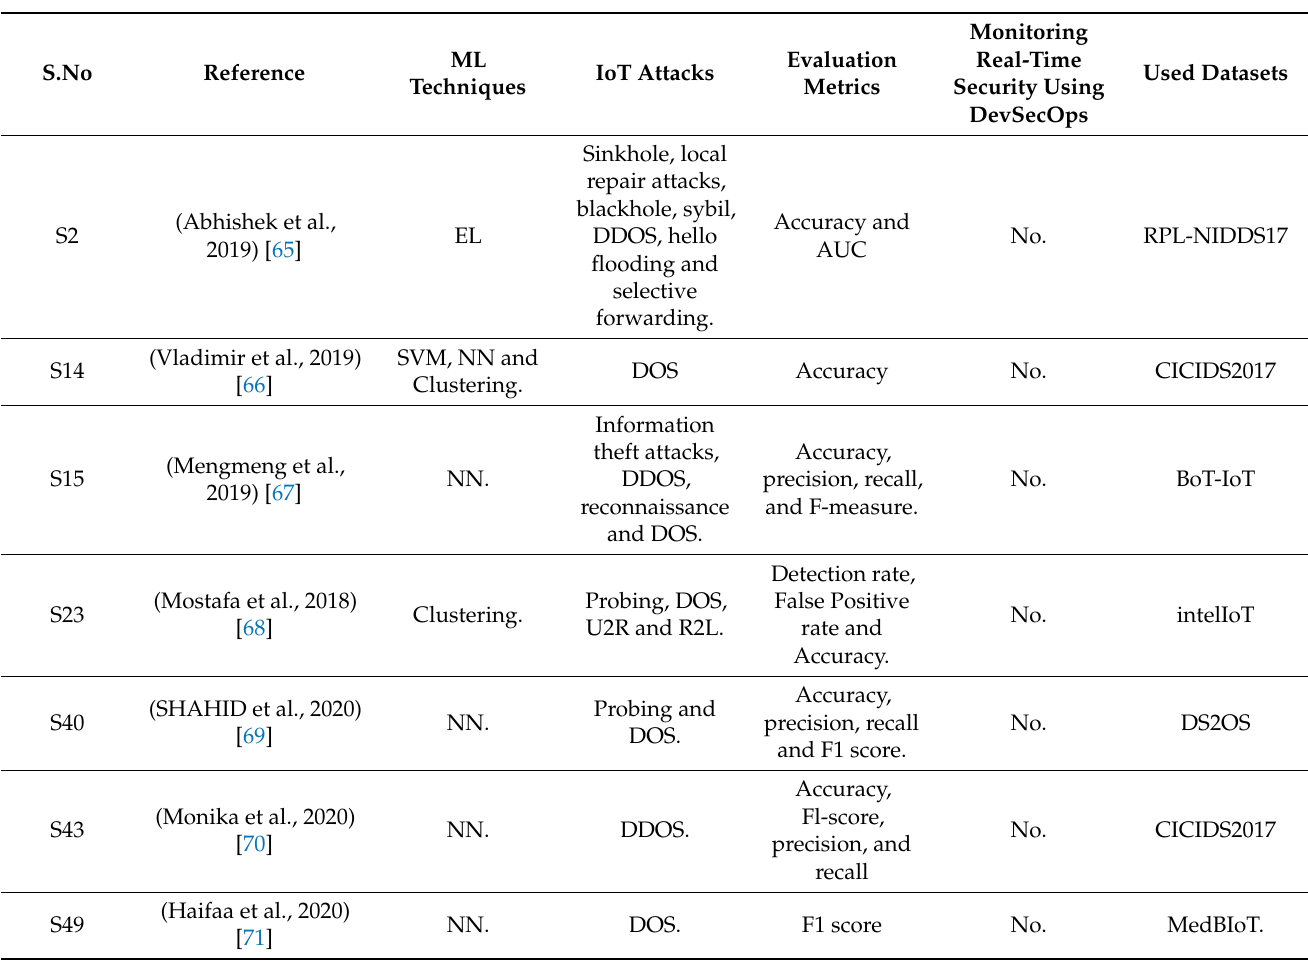
Table 8. Other public